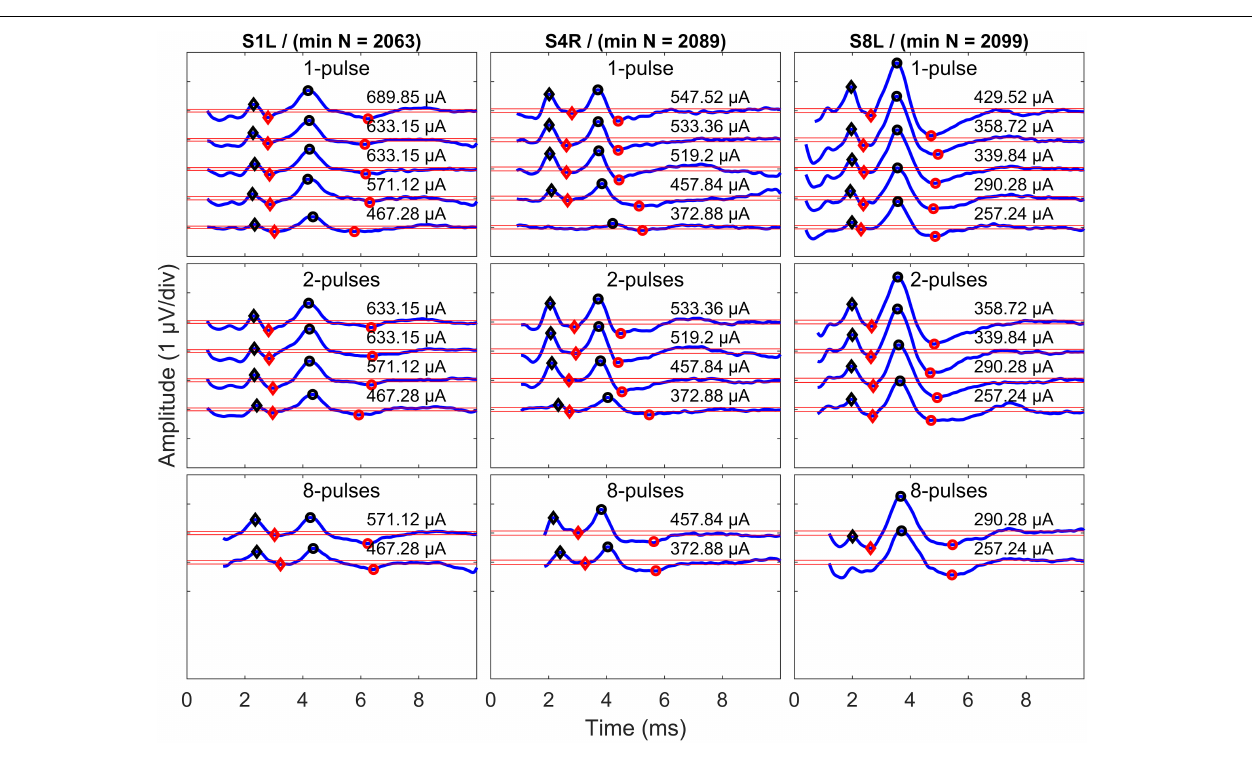
(median: 7.17 dB). With increasing number of pulses, both THRs levels and MCLs decreased monotonically, almost for every measurement and patient, with steeper drops for THRs. The median THR levels over all subjects dropped by about 6.30 dB